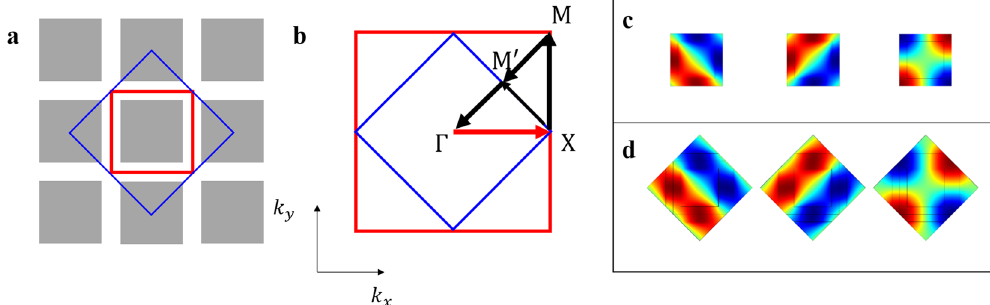
Figure 1. Two types of unit cells considered and their modes: ( a ) Original (O) and enlarged (E) unit cells. The red solid square represents unit cell type O in a conventional manner and blue solid diamond is unit cell type E. (b) The first Brillouin zones for two types of unit cells. The blue solid diamond denotes unit cell type E and the red solid square represents the zone for unit cell type O. ( c , d) Bloch modes of unit cells at a Dirac-like point. Both unit cell types O and E have one quadrupole mode and two dipole